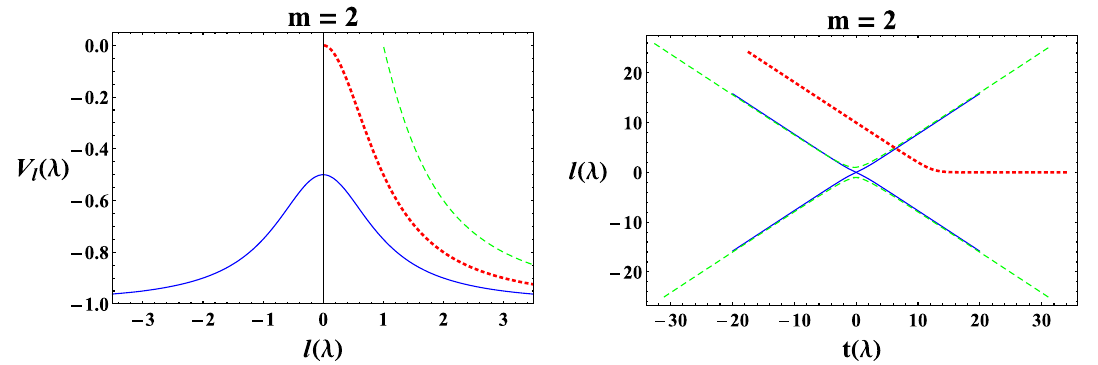
Fig. 5 Effective potential and geodesics for 4D-GEB wormhole ( m = 2): dotted-red, dashed-green, and continuous-blue curves representing – Trapped, Returning and Crossing geodesics respectively